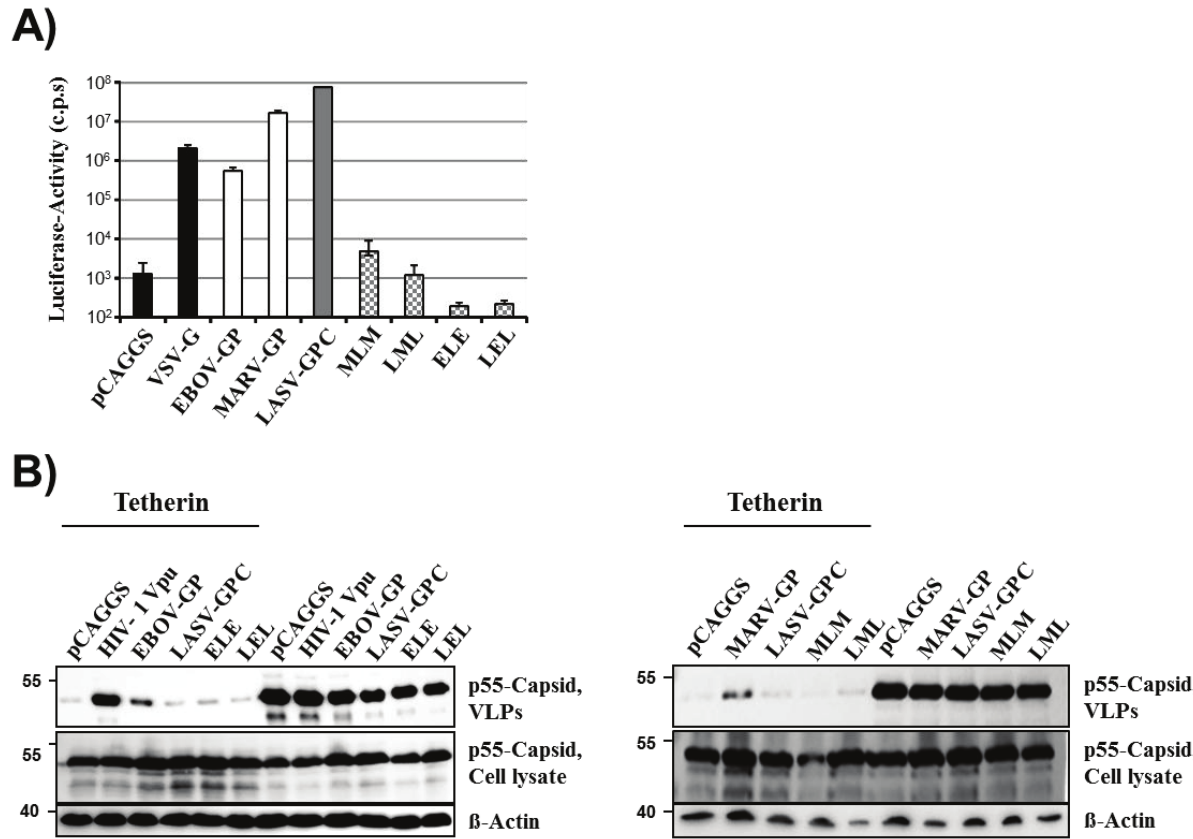
Figure 5. The filoviral transmembrane domain is necessary but not sufficient for tetherin antagonism. ( A ) Transduction of cells with pseudotypes bearing the indicated chimeric GPs was analyzed as described in Figure 1B. One representative experiment is